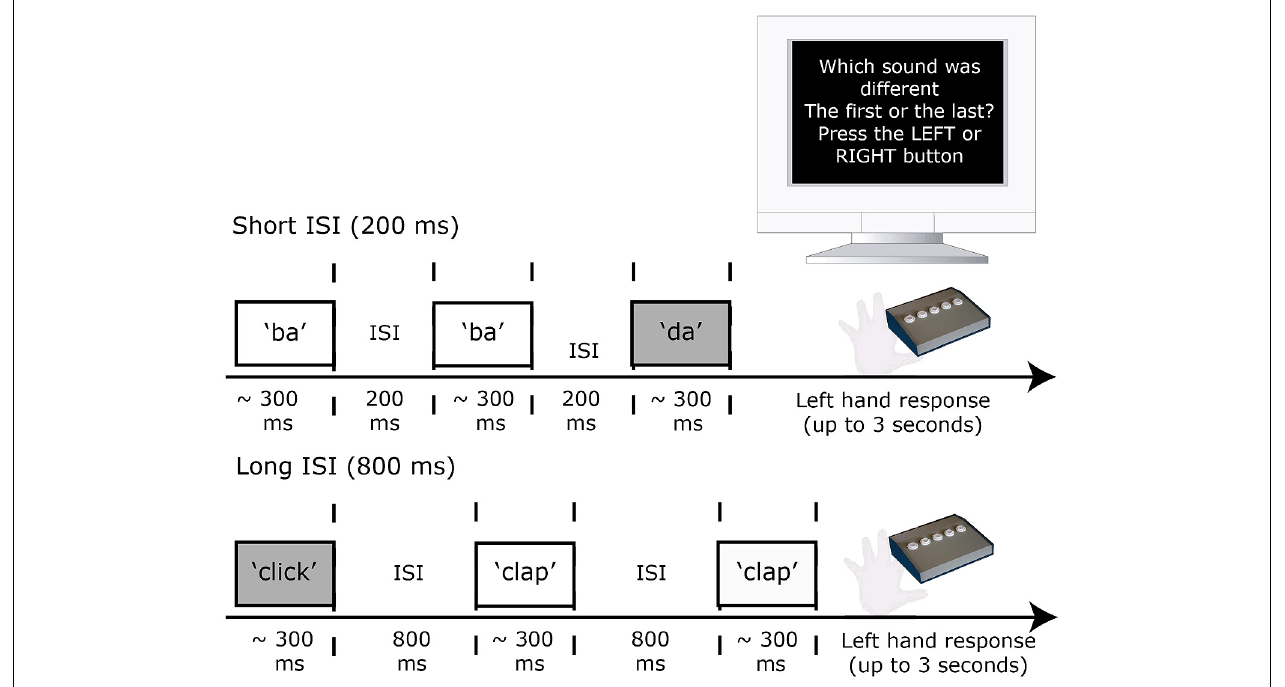
FIGURE 2 | Experimental design for the discrimination (AXB) task used pre and post stimulation. The across- and within-category sound triplets were heard at two ISIs (200 and 800 ms). Responses were made via a button-press response with the left hand. After 3 s without response the next trial began.